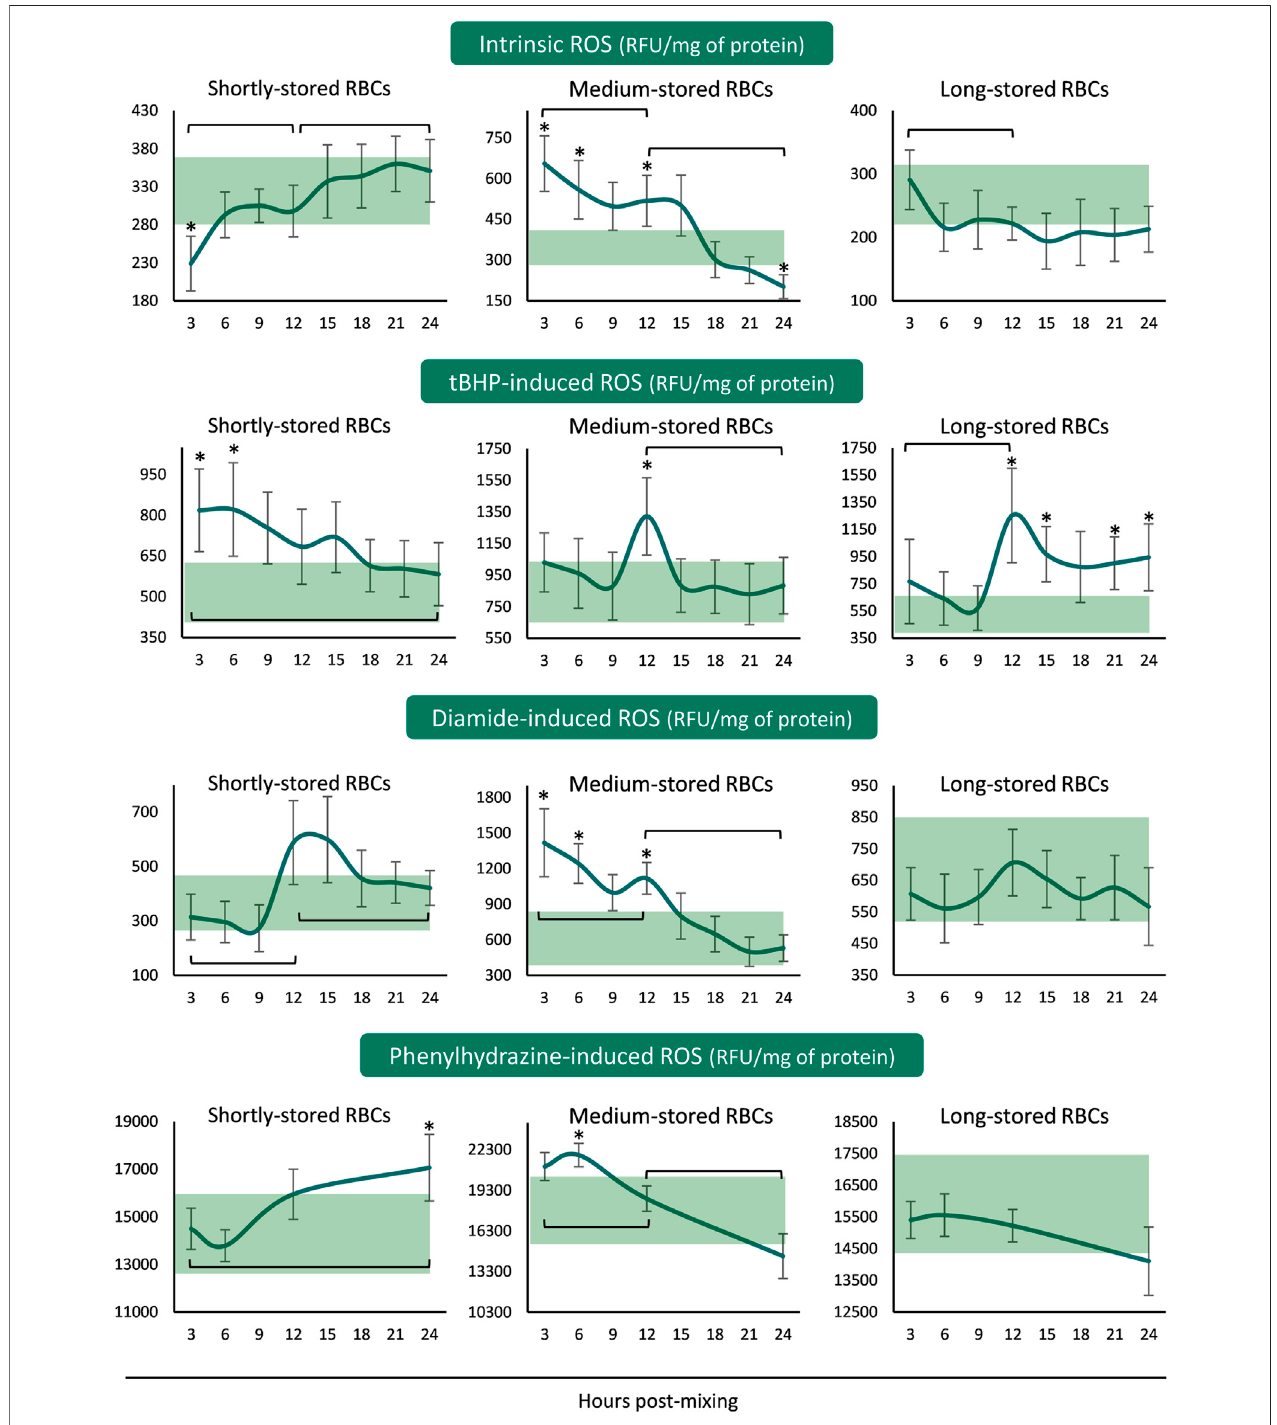
FIGURE2| Reactiveoxygenspecies(ROS) ofreconstitutedstoredredbloodcellsinfreshlydrawnplasmawithorwithoutexternalstimuli.Baselinelevelsofstored RBCs in the cold (4 ° C) are shown by transparent horizontal bands (band thickness is representative of the standard deviation [SD]). (*) p < 0.050 reconstituted RBCs vs. baseline RBCs in the cold; brackets show differences with p < 0.050 between 3, 12, and 24 h post reconstitution.